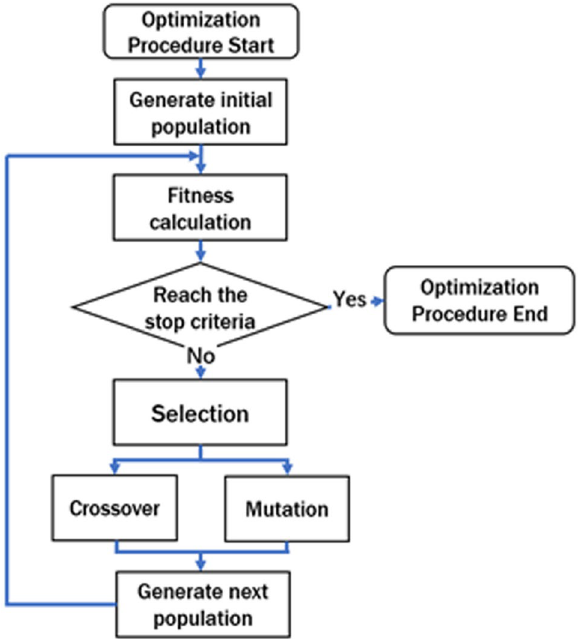
Figure 1. Flowchart of genetic algorithm optimization. Note that in this paper, we used binary coding to express FSS structures. Selection, crossover, and mutation are the fundamental operations in